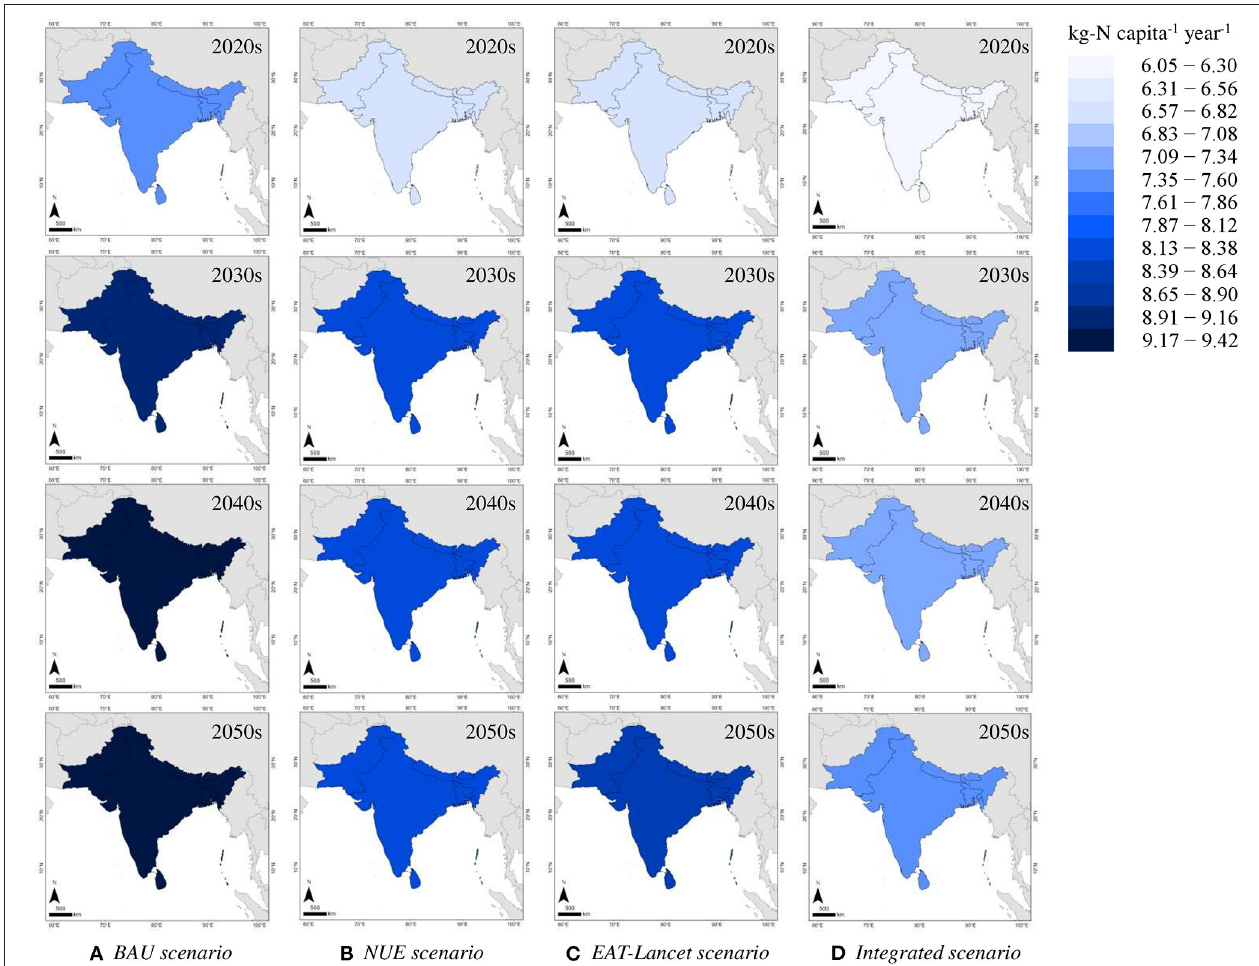
FIGURE 5 | Expected food N footprint of the ISC from the 2020s to the 2050s under different scenarios (A) BAU scenario, (B) NUE scenario, (C) EAT-Lancet scenario, and (D) Integrated